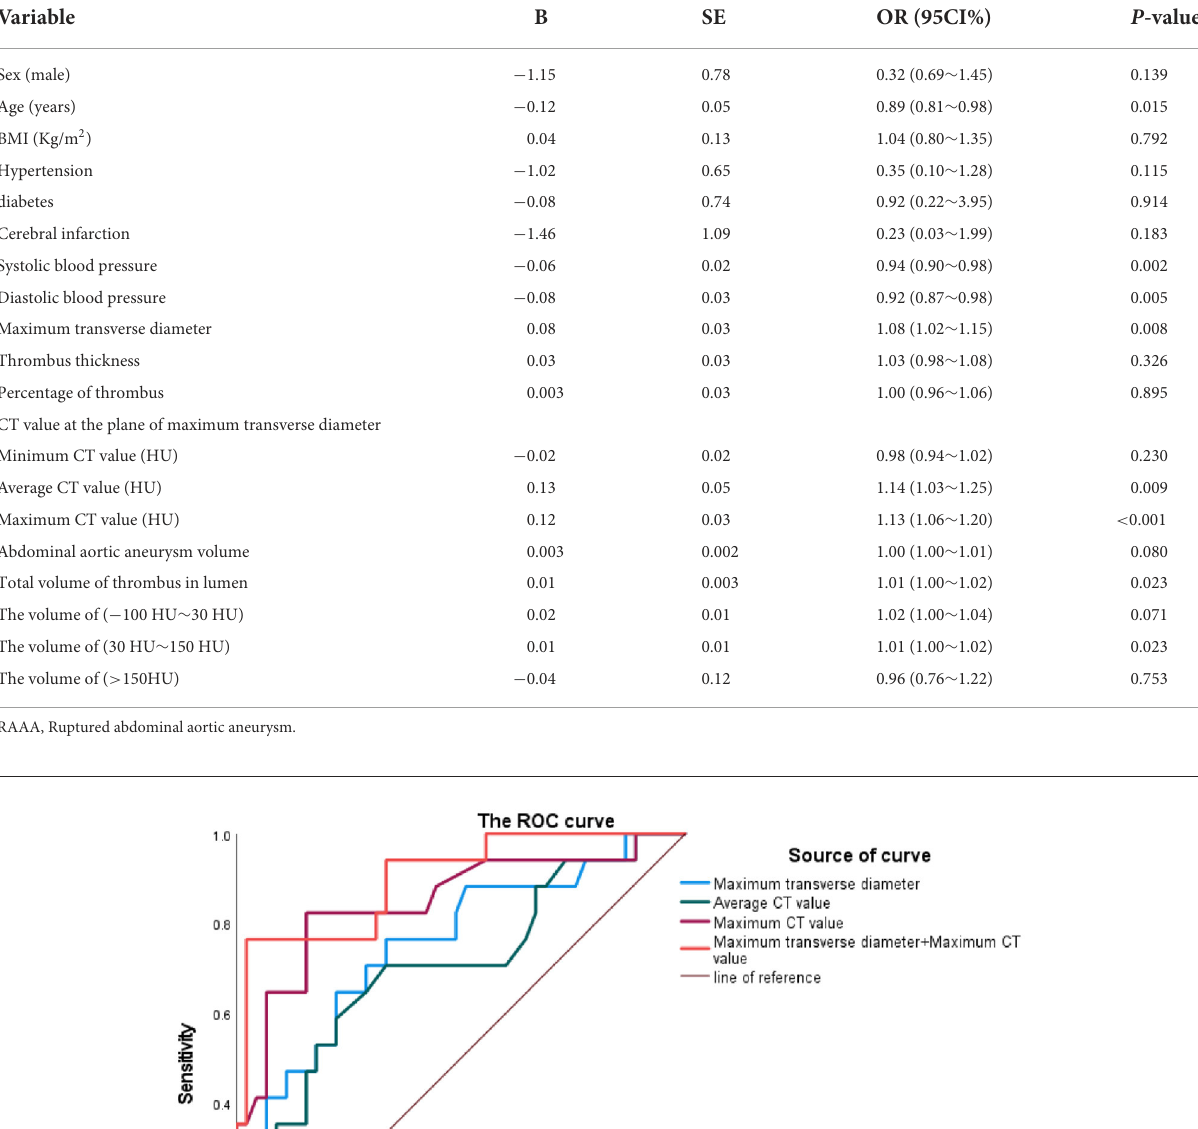
TABLE 4 Univariate logistic regression analysis of clinical variables and RAAA.